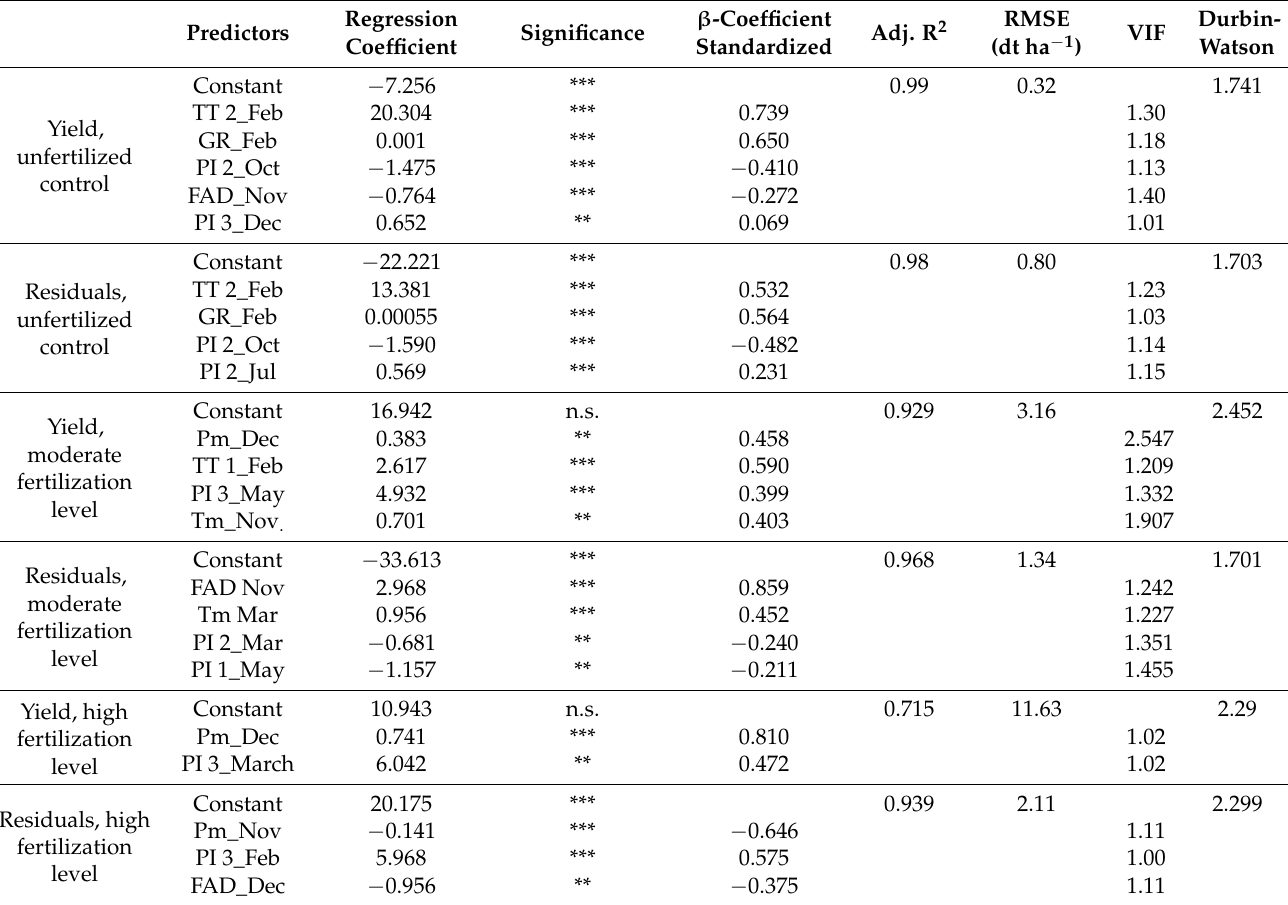
Figure 4. Measured and calculated yields, with monthly independent variables for different fertilization levels (unfertilized plots (N0), moderately fertilized plots (N1), and highly fertilized plots (N2)). Table 5. Multiple regression calculations of residuals and yields, with monthly climate parameters for different levels of fertilization (abbreviations are given in Table